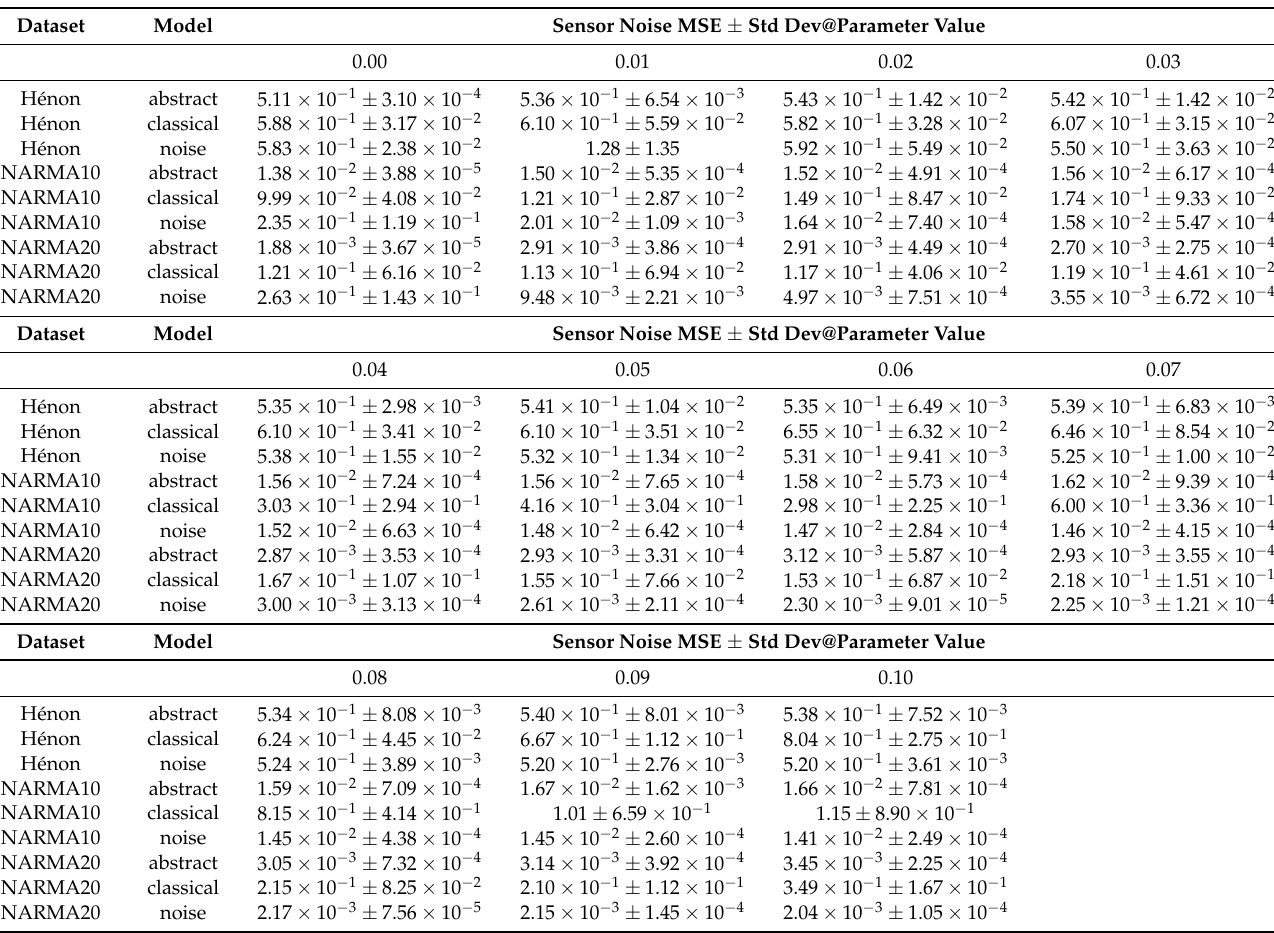
Table A2. Average MSE for the experiments simulating sensor noise over 10 experiment runs. The parameter gives the amplitude of the noise added to the sensor